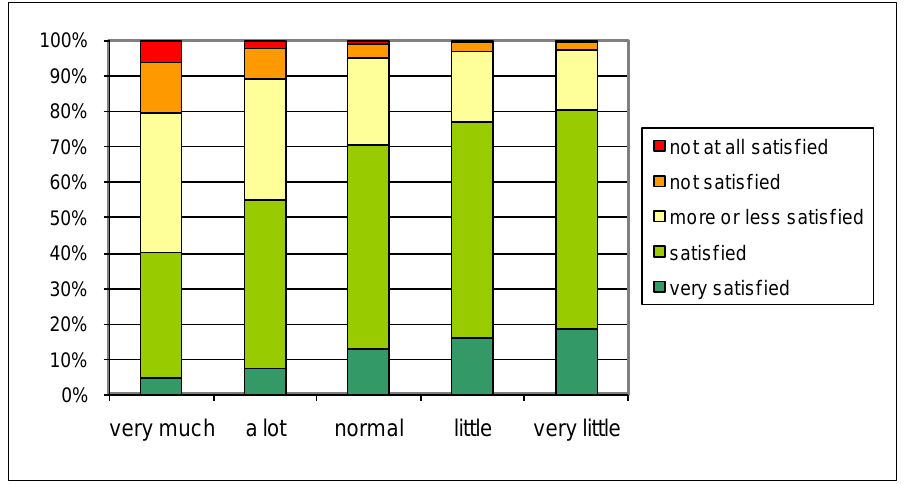
Figure 8. Probabilistic estimate of global living quality in the neighborhood (vertical) for different traffic intensities (horizontal); to be compared with Figure